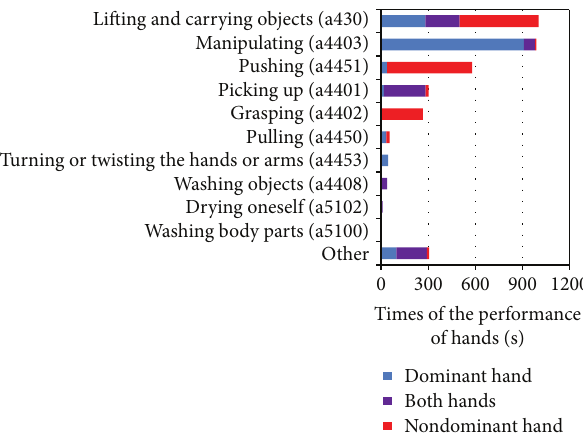
Figure 7: Time of actions for each hand in cooking